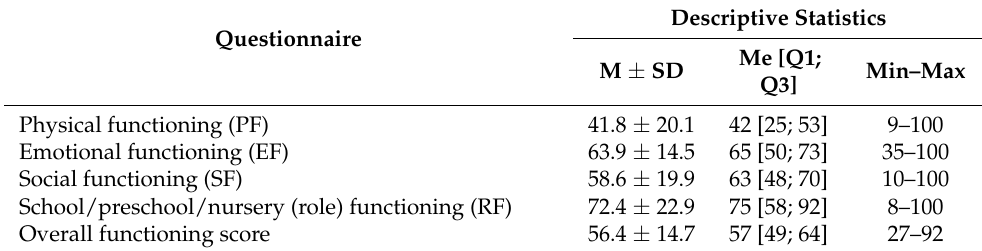
Table 2. Survey results for the parents of 52 children with myelomeningocele.